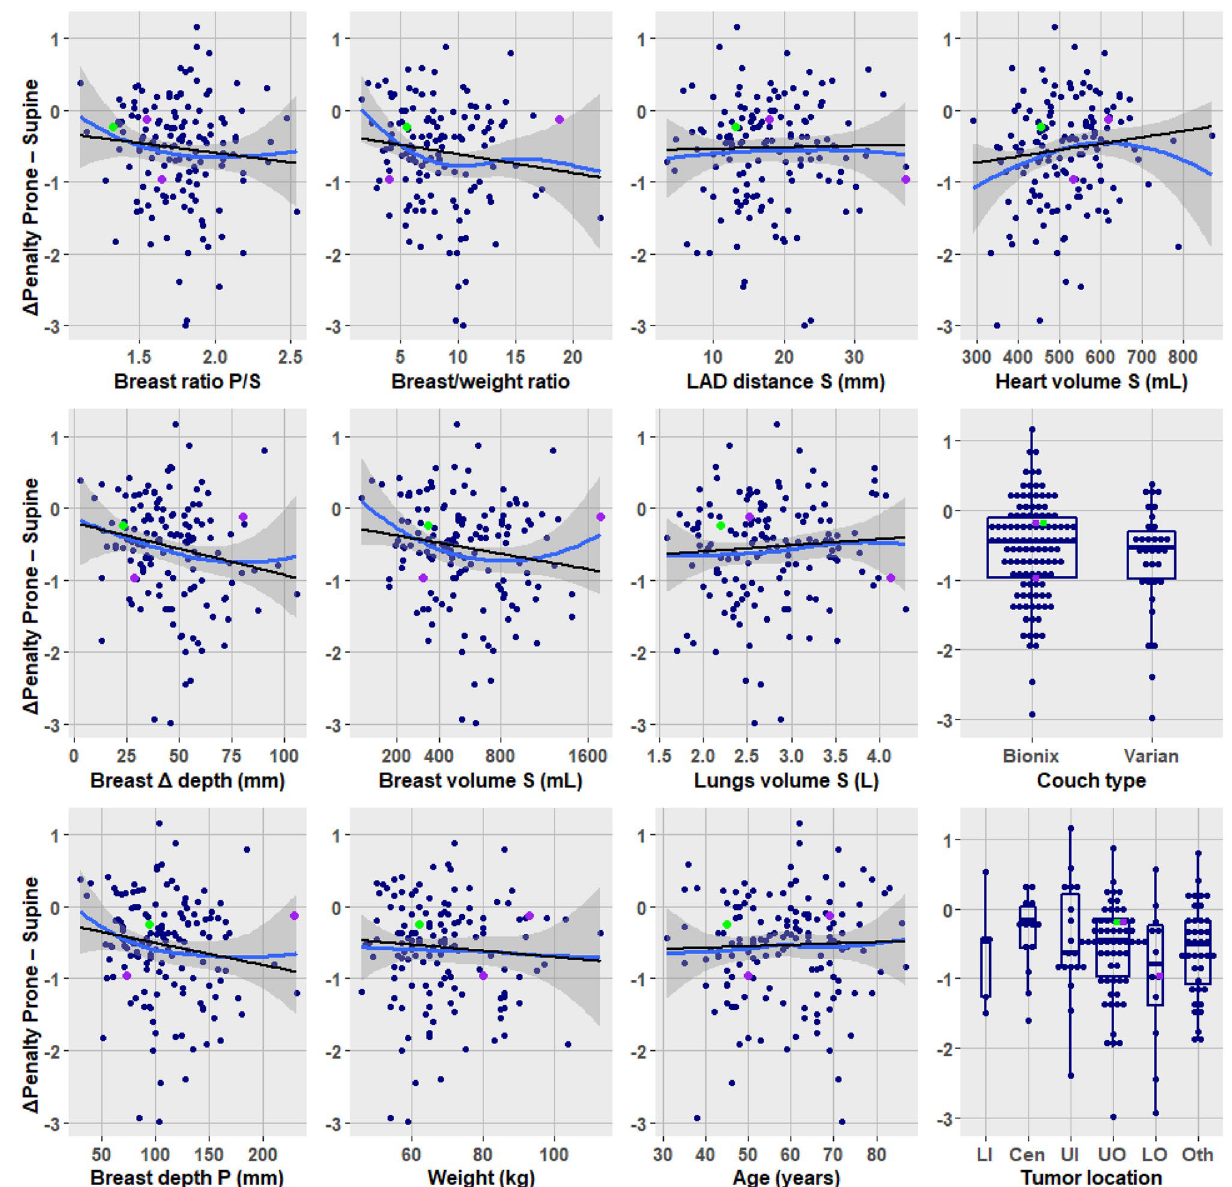
Figure 4. The ΔPenalty prone–supine as a function of characteristics. Negative ΔPenalty indicates a dosimetric advantage with prone (reduction of penalty). Black line, robust linear regression. Blue curve, local polynomial smooth fit (display shows no major departure of linearity). Grey band, 95% confidence. Green, breast implant; purple, bilateral cases. Tumor location: abbreviations in Table The MADDs pertaining to the right breast plans (Fig. 2) mirror those of the left breast previously reported (Fig. 4 in 8 ). The difference pertains to heart doses that were higher with the left breast. The previous left side median heart MADD were 3.4 prone and 1.9 supine in deep inspiration breath-hold, as compared with the pre- sent right side median heart MADD 1.9 prone and 1.3 supine free-breathing (Table 2). Between right and left, the left side higher heart doses prone and supine, (3.4 and 1.9) > (1.9 and 1.3), is attributable to the heart nearer to the treatment fields. Between prone and supine, the heart ΔMADD difference, larger left (Δ =|3.4–1.9|= 1.5) than right (Δ =|1.9–1.3|= 0.6), is attributable to breath-hold. The lung doses delivered to the patients in supine position were low. The mean ipsilateral lung dose normal- ized to a breast prescription of 50 Gy was 4.8 Gy (9.6 PoPD, Table 2). That is nearly half less than the 8.4 Gy reported in the literature for whole breast/chest wall radiotherapy 35 . The low supine lung dose can be ascribed to our choice of no PTV expansion. A dosimetric study comparing 0, 5 and 10 mm PTV expansion from the breast target volume reported a mean dose to combined lungs of 2.0–5.0 Gy, 2.8–5.1 Gy and 3.0–5.2 Gy, respectively 36 , which correspond well with our combined lungs average dose of 2.5 Gy supine. Prone further reduced the ipsilateral lung dose to the equivalent of 1.4 Gy (2.8 PoPD, Table 2). The corresponding proportional reduction of the dose to the ipsilateral lung obtained with prone was 70.8% = [(4.8 Gy–1.4 Gy) ÷ 4.8 Gy] ∙ 100. That is well